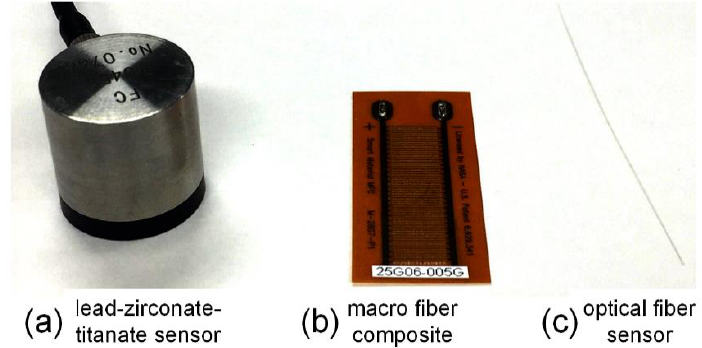
Figure 1. The typical ultrasonic sensors.